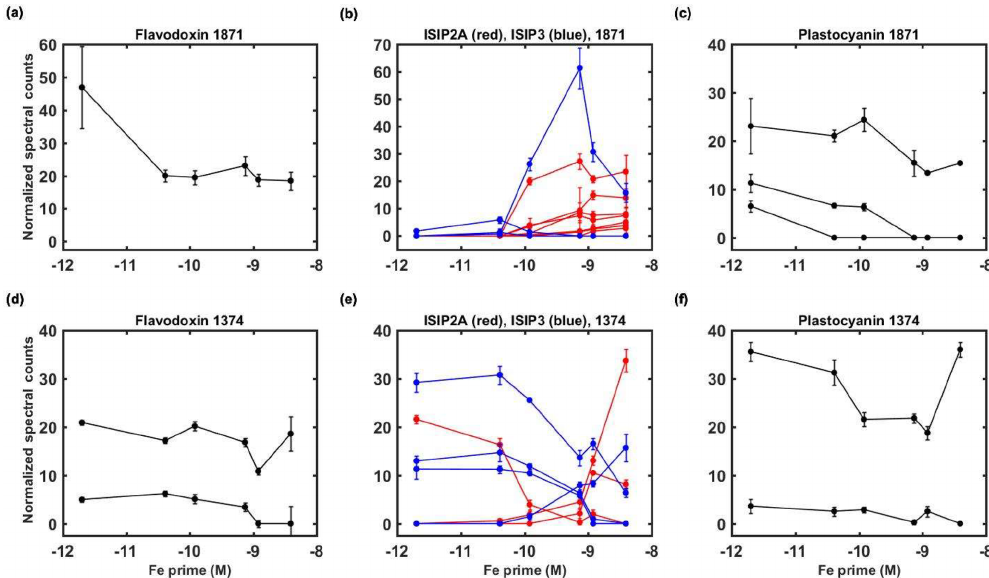
Figure 6. Examination of iron stress response proteins in P. antarctica strain 1871 (a, b, c) and 1374 (d, e, f) . Relative protein abundance is shown as normalized spectral counts; spectral counts have been normalized across experiment treatments for each strain, but not to the maximum of each protein as used in prior figures to allow for comparison of abundance for similar isoforms. Error bars indicate the standard deviation of technical triplicate